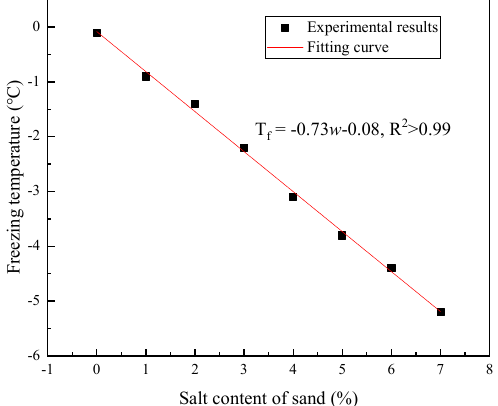
Figure 4. Variation in the freezing temperature with the salinity.